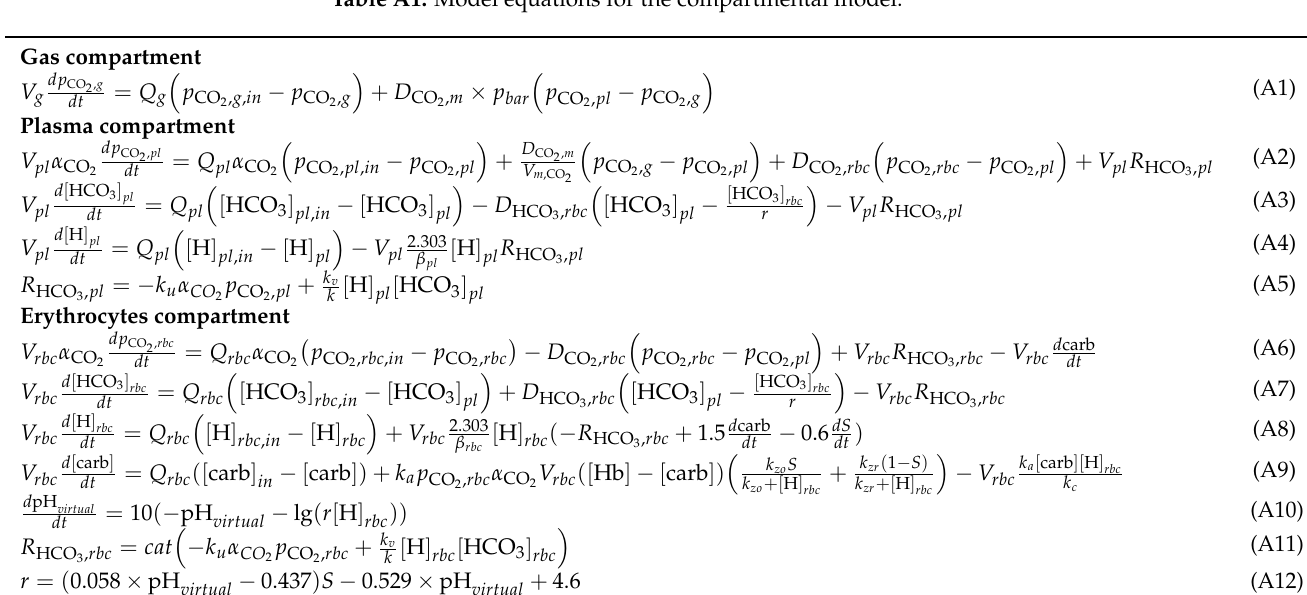
Table A1. Model equations for the compartmental model.